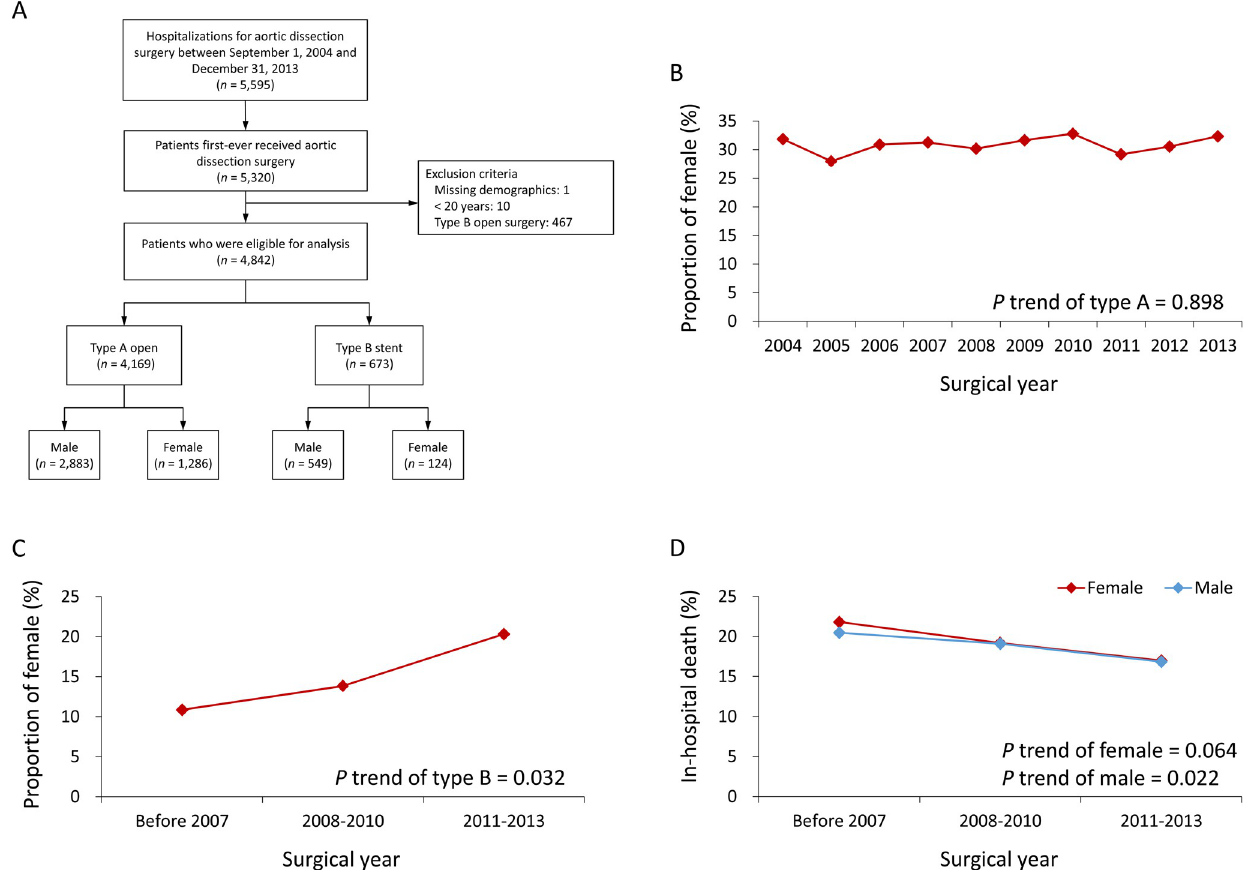
Fig 1. Flow chart for patient selection (A), epidemiology for the trend of sex distribution in receiving type A open surgery (B) and type B stent surgery (C) and the trend of in-hospital mortality among the acute aortic dissection surgeries in the males and females (D) over the study period. Due to the small sample size for type B stent surgery, the surgical year was divided into three